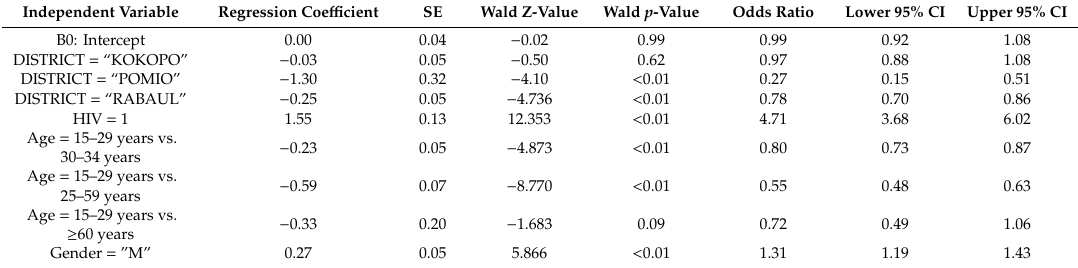
Table 3. Multivariable logistic regression model 1 (excluding ethnicity) for risk factors associated with HBsAg positive blood donors in east New Britain province (ENBP),